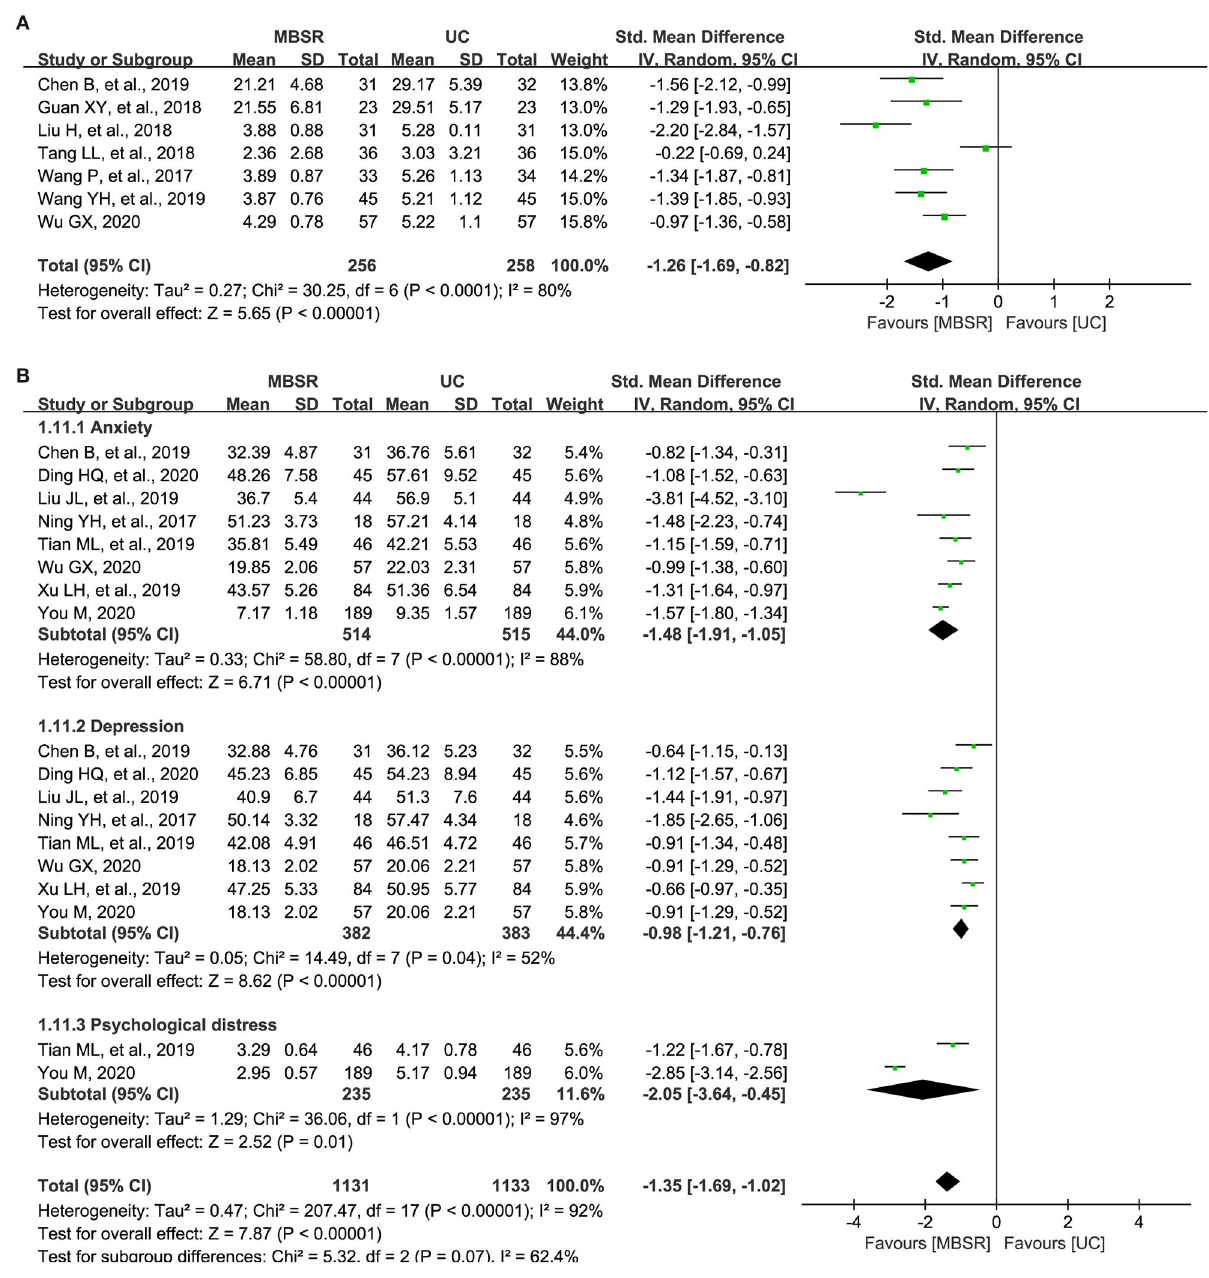
FIGURE 2 | Forest plot of comparative effectiveness between mindfulness-based stress reduction (MBSR) program and UC in terms of cancer-related fatigue (A) and negative psychological states (B) . MBSR, mindfulness-based stress reduction; UC, usual care; R-PFS, Revised Piper Fatigue Scale; CFS, Cancer Fatigue Scale; SAS, Self-rating Anxiety Scale; SDS, Self-rating Depression Scale; HAMA, Hamilton Anxiety Scale; HAMD, Hamilton Depression Scale; SD, standard